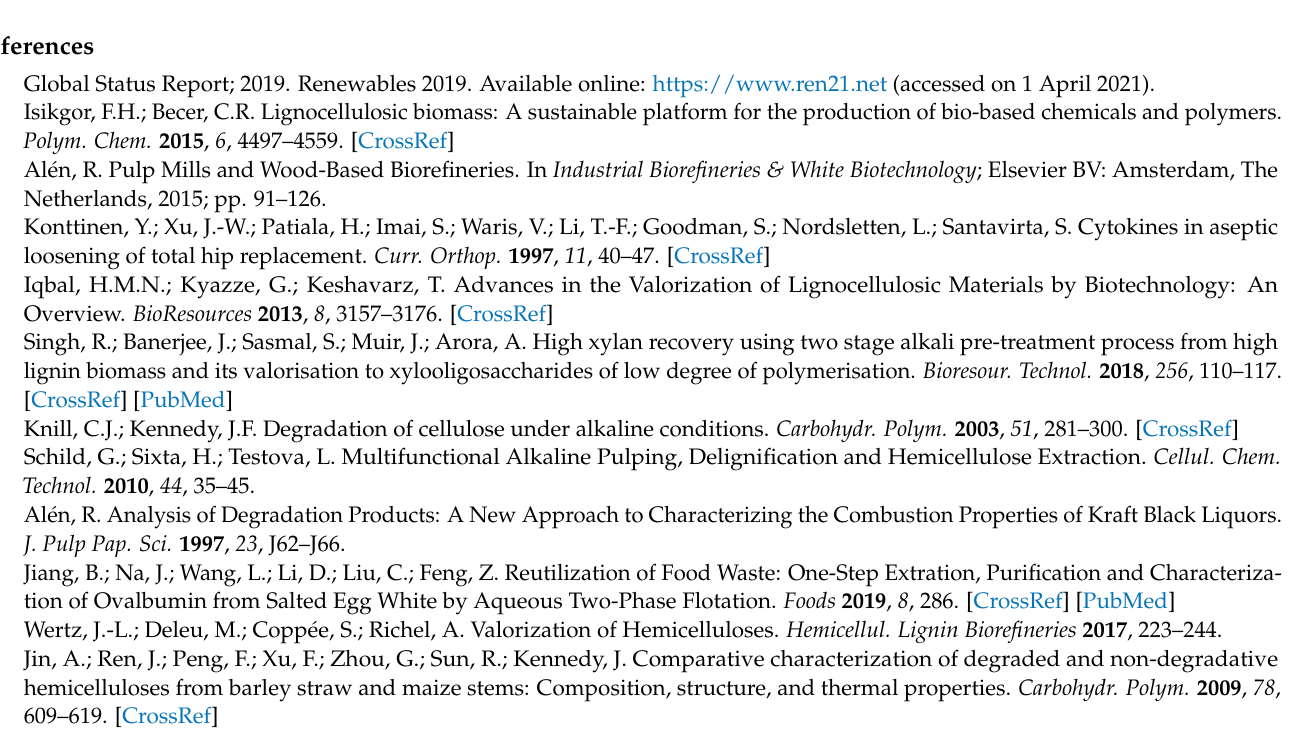
to the C-atom; Figure S3: SEC-RI chromatograms of hemicelluloses extracted from the sulfite pulp; Table S1: Results and yields obtained during hemicelluloses extraction procedure; Table S2: Total signals assignation of hemicelluloses extracted from the sulfite pulp in D 2